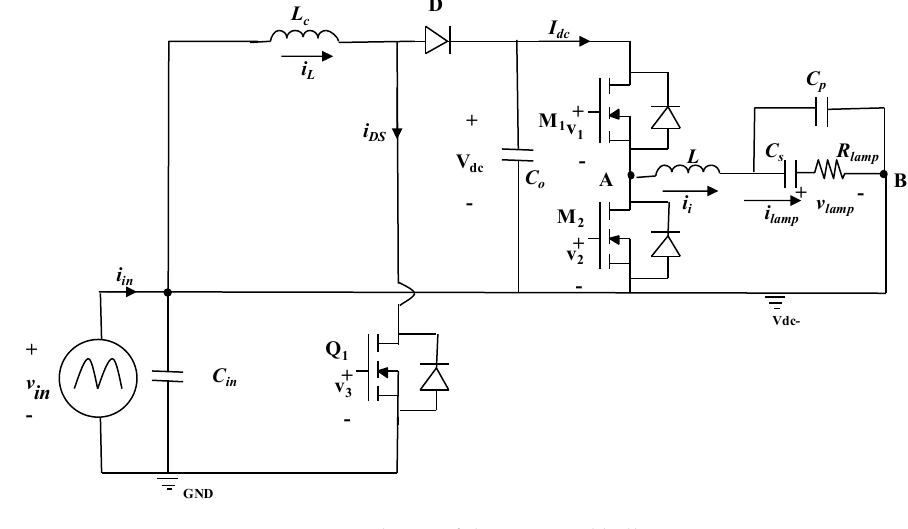
Figure 6. Scheme of the proposed ballast.